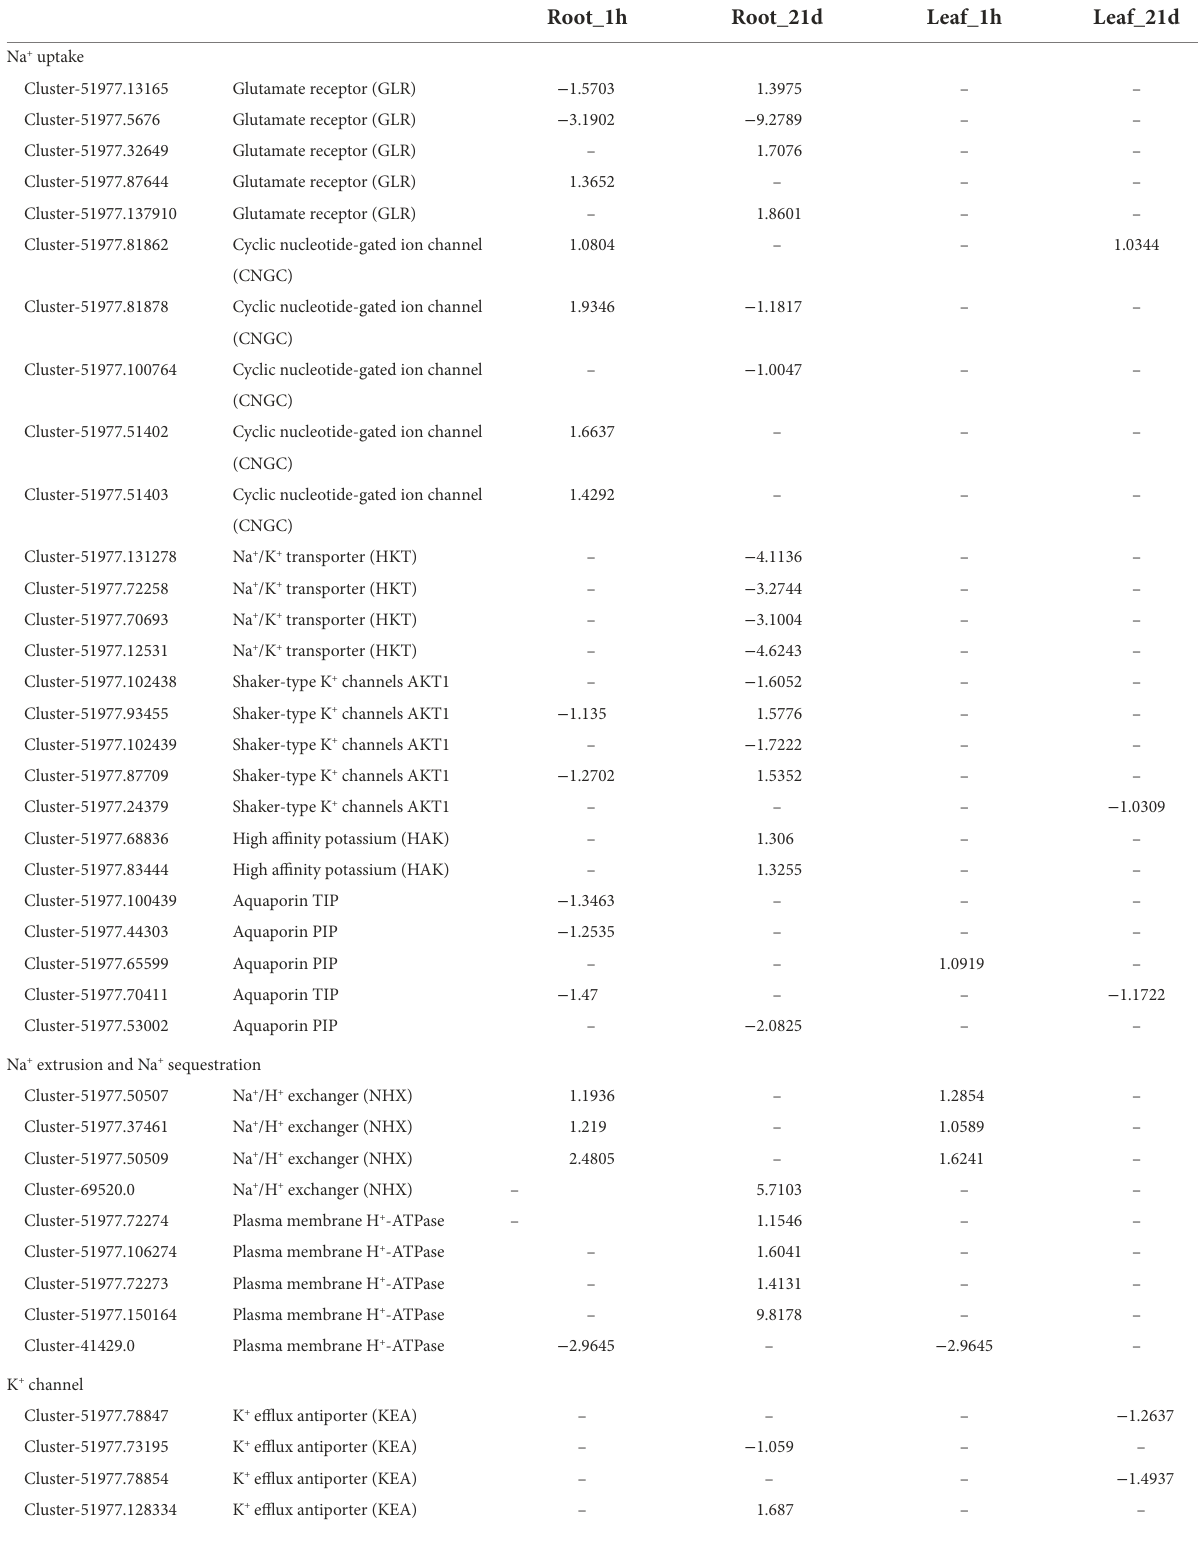
TABLE 1 Differentially expressed ion transporters in roots and leaves under salt stress. Cluster